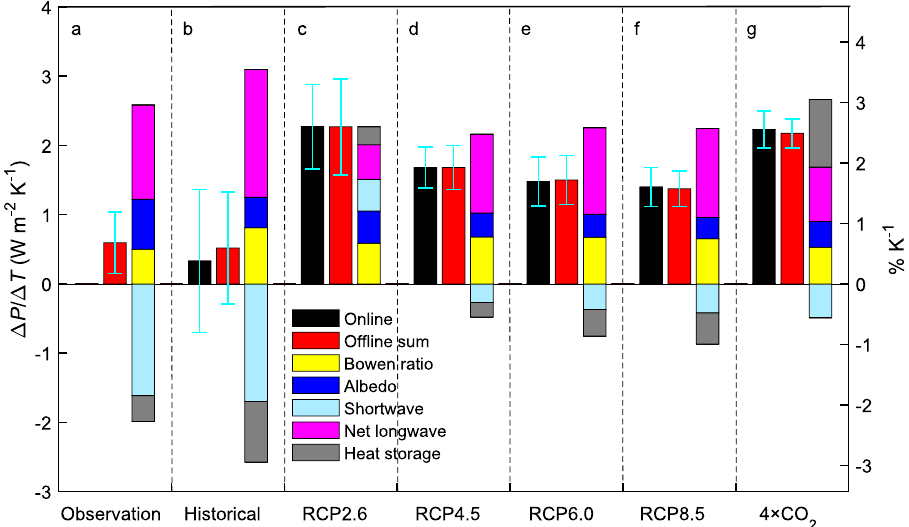
Fig. 2 Component contributions to global precipitation temperature sensitivity. a Results from observations of ocean surface energy balance. b – g CMIP5 scenarios are labeled at the bottom. According to Eq. (1), global precipitation temperature sensitivity Δ P / Δ T is partitioned into temperature sensitivity of changes in Bowen ratio, ocean surface albedo, incoming shortwave radiation, net longwave radiation (incoming longwave radiation minus outgoing longwave radiation), and ocean heat storage. Black: climate model online calculation; red: sum of the fi ve component contributions; yellow: contribution by Bowen ratio change; blue: contribution by surface albedo change; light blue: contribution by a change in surface downward shortwave radiation; magenta: contribution by a change in surface net longwave radiation; gray: contribution by a change in ocean heat storage. Error bars are ± one standard deviation. The magnitude and percentage of Δ P / Δ T are given by the left and the right y axis, respectively. Description of scenarios is given in Fig. 1